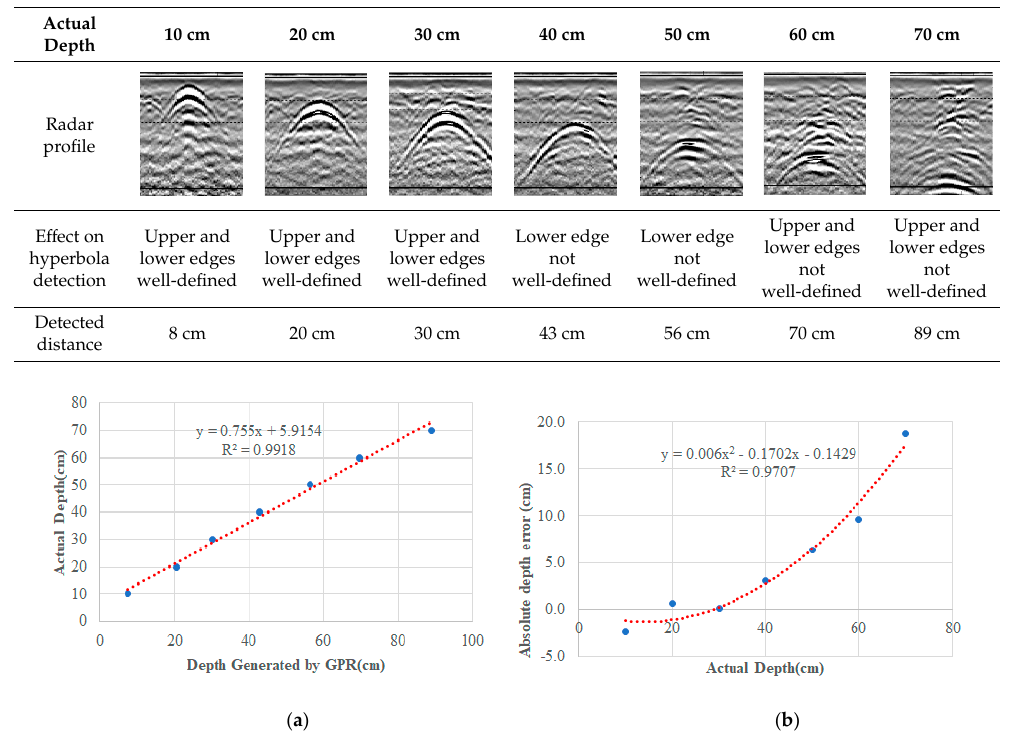
Table 5. Radar profiles of a root buried at di ff erent depths.